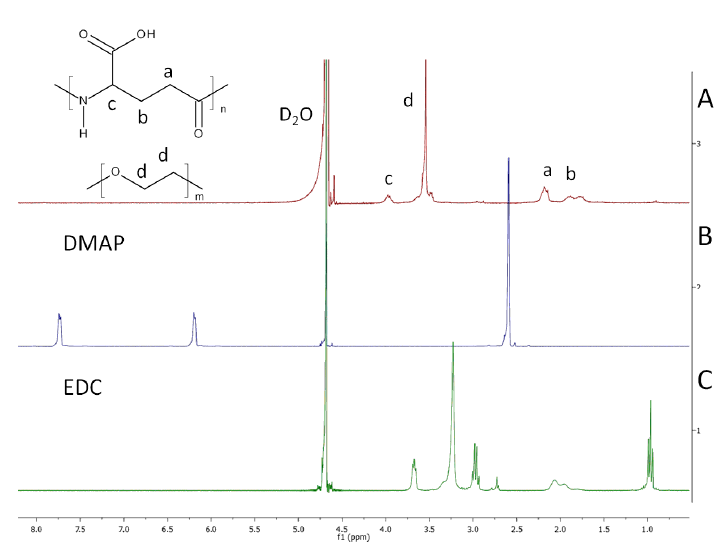
Figure 1. Obtained sample 1H NMR spectra as result of hydrolysis of ( A ) γ -PGA–PEG1000 hydrogel, ( B ) DMAP, and ( C ) EDC.